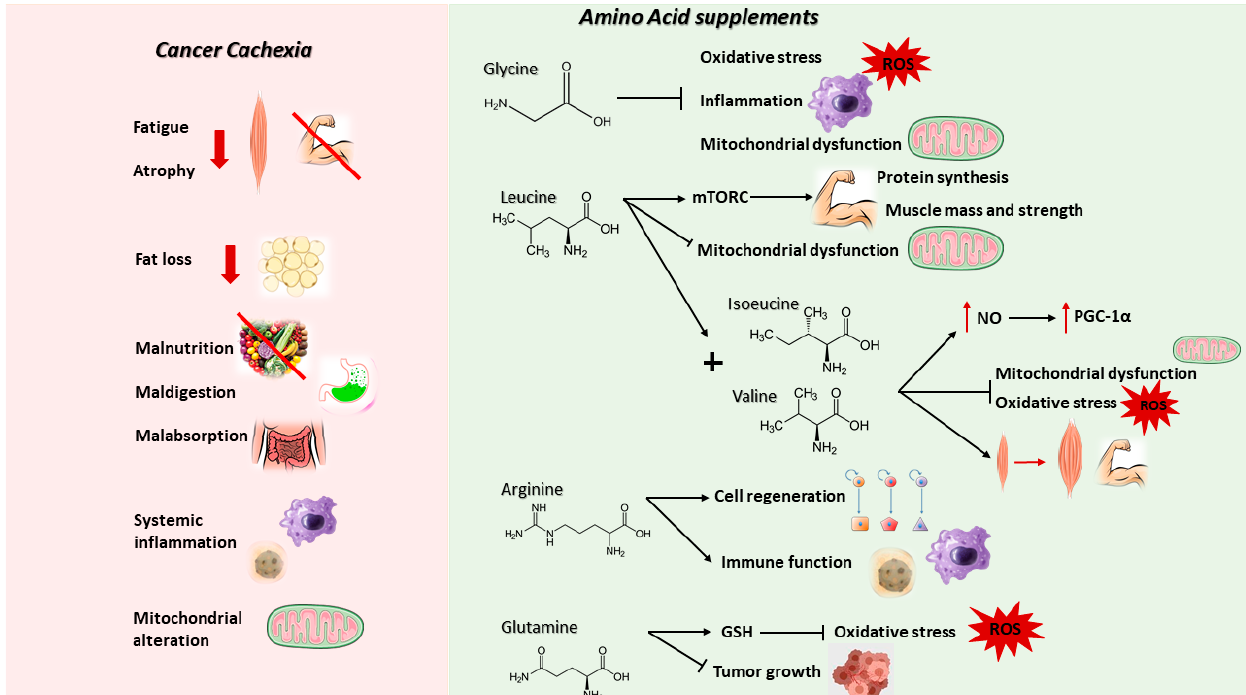
Figure 3. Main alterations underlying cancer cachexia (left) and the impact of specific AA supple- mentation in counteracting such manifestation or promoting beneficial anti-tumor effects (right). A detailed description of the anti-cachexia action is provided in the following text. The icons used were obtained at: https://smart.servier.com/ (accessed on 10 November 2022).